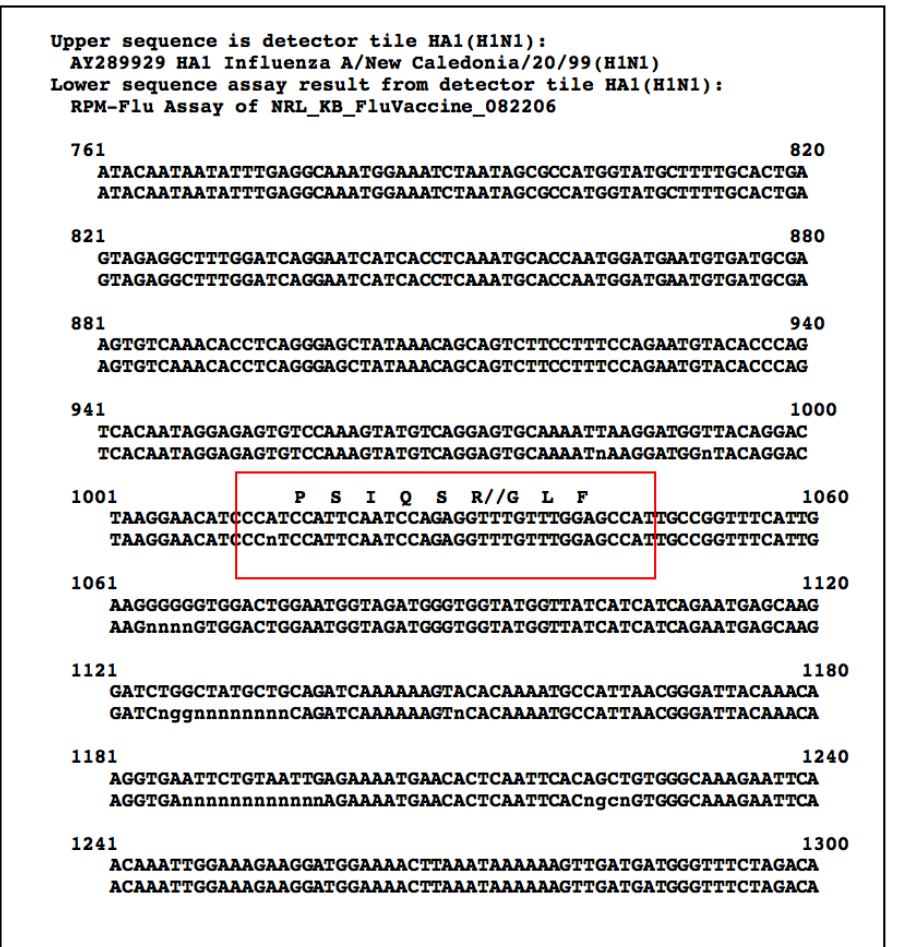
Figure 2. RPM-Flu assay-generated sequences from analysis of tri-valent influenza virus vaccine. A 540-nucleotide segment of the reported HA1 hemagglutinin sequence is shown aligned to the corresponding RPM-Flu HA1 gene detector tile sequence. This segment of the RPM- Flu HA1(H1N1) detector tile spans the locus of the A/H1 hemagglutinin peptide cleavage site (red box).